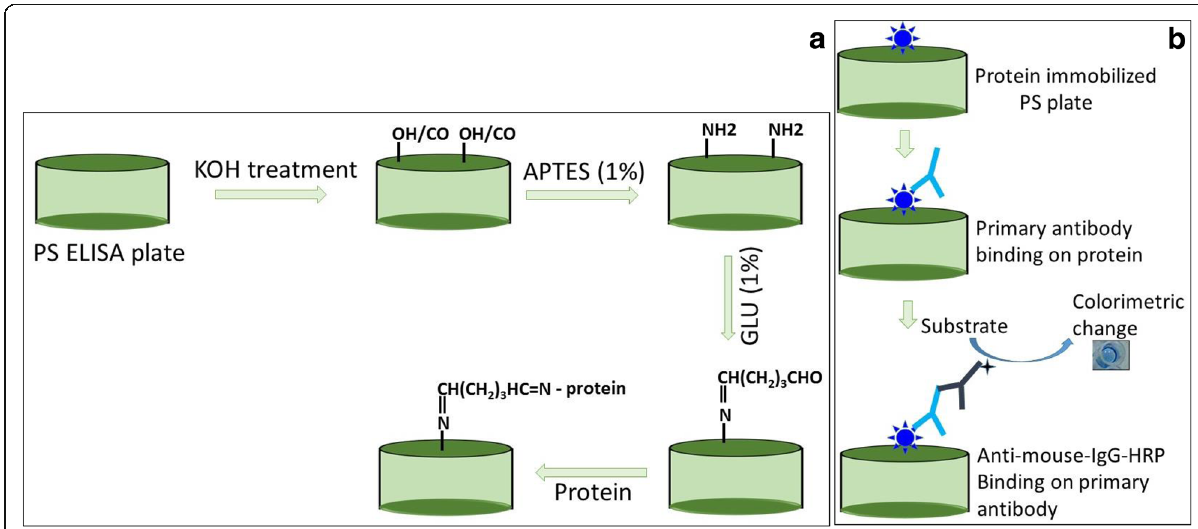
Fig. 1 Schematic representation of chemically modified ELISA ( a ). The ELISA surface was modified chemically using APTES and GLU after potassium hydroxide treatment. The antigen was immobilized on the GLU-modified surface. b The immobilized antigen was detected by its partner